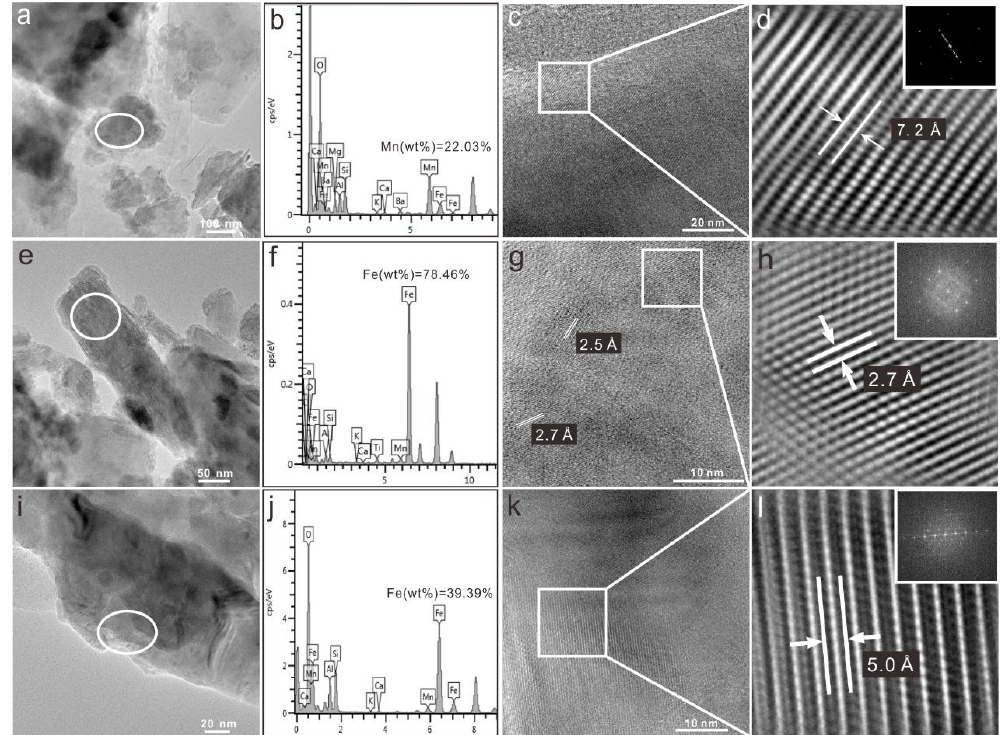
Figure 10. TEM morphology ( a , e , i ), chemical composition ( b , f , j ), lattice photograph ( c , g , k ) and diffraction pattern ( d , h , l ) of Mn-rich and Fe-rich grains in the rock Fe/Mn coating. Panels ( b , f ) and ( j ) show the chemical composition of the selected oval regions in panels ( a , e ) and ( i ), respectively. The lattice fringes and diffraction patterns in panels ( d , h ) and ( l ) are the FFT and inverse FFT results of selected rectangular regions in panels ( c , g ) and ( k ), respectively.